Question: Which visualization type does this figure use?
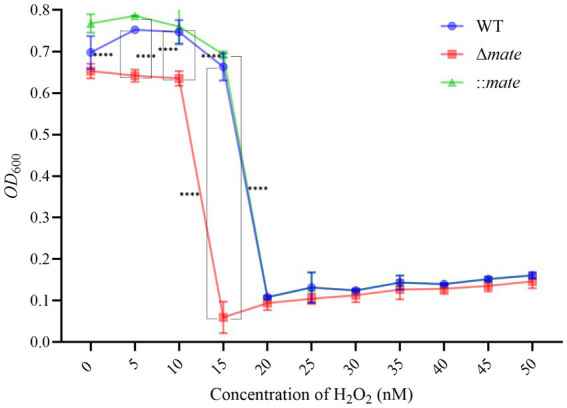
Answer: line